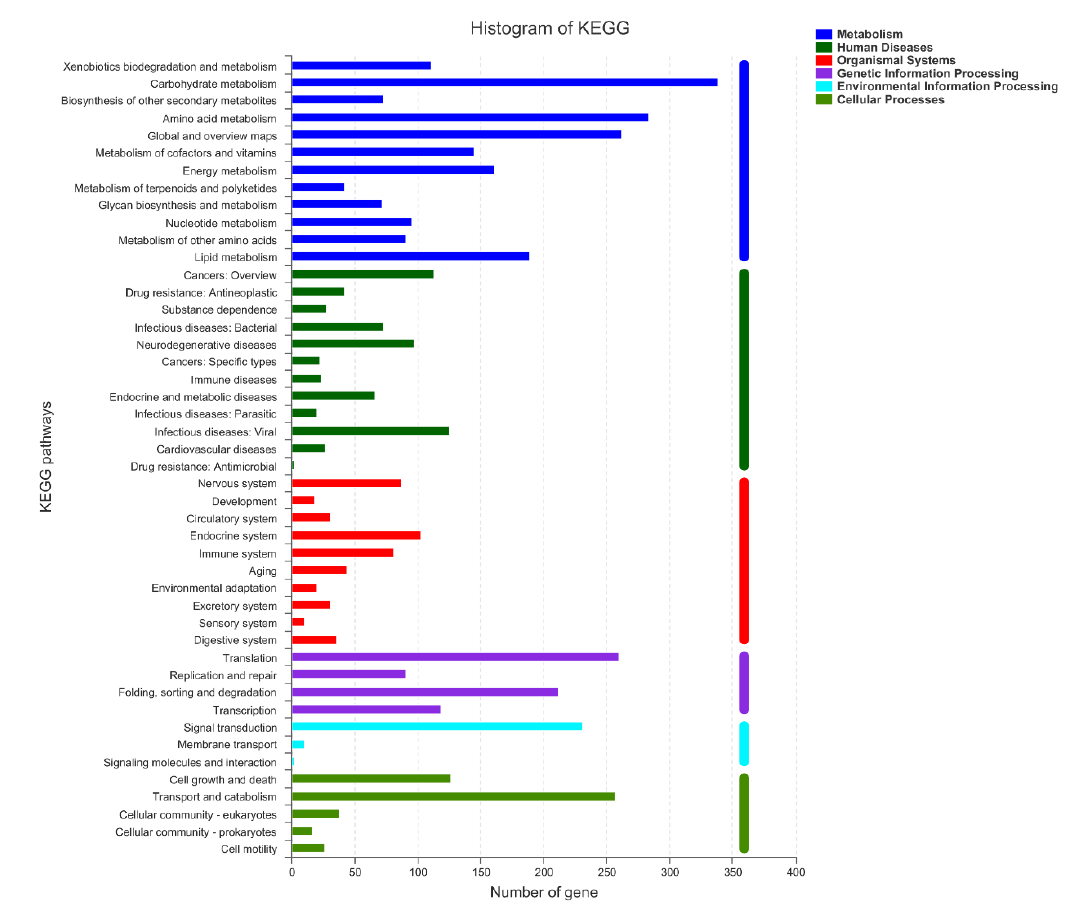
Figure 9. KEGG function classification of Unigenes from A. japonicas PJ01. 3.10. Carbohydrate Active Enzymes (CAZyme) Database Annotated of Carbohydrate Active Enzyme Gene Compared with the CAZyme database, 601 genes were annotated. The genes of glycoside hydrolases (GH) accounted for 45.42% (273), which was the most. The genes of glycosyl transferases (GT) (99), carbohydrate esterases (CE) (103) and auxiliary activities (AA) (95) accounted for 16.47%, 17.14% and 15.81%, respectively. The complete genome of A. japonicas PJ01 also included 12 polysaccharide lyases (PL) and 19 carbohydrate-binding modules (CBM) (Figure 10). GH contains 12 genes related to polygalacturonase, 8 genes related to xylanase and 10 genes related to carboxymethyl